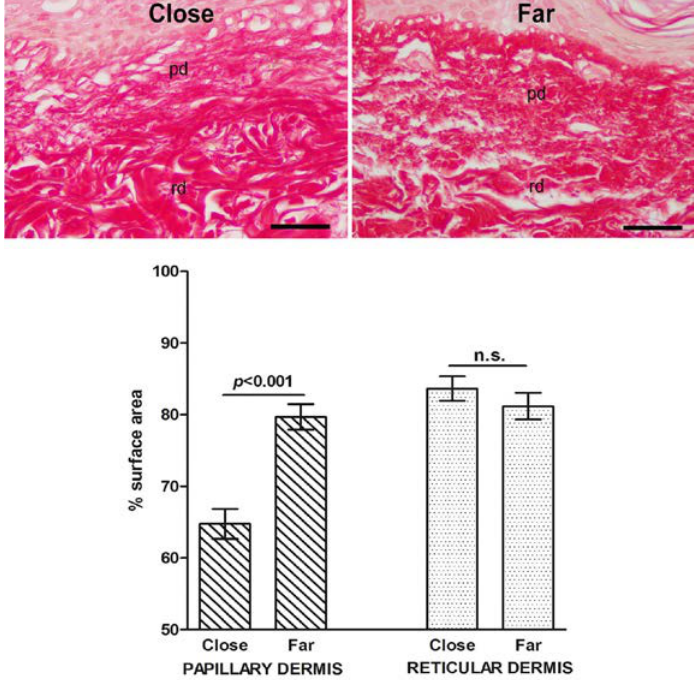
Figure 4. Light microscopic appearance and morphometry of collagen fibers from skin areas located close to and far from (3–5 mm) the surgical wound; pd: papillary dermis, rd: reticular dermis. The collagen fiber meshwork is slightly, albeit significantly, reduced in proximity to the wound. PSR staining; bars = 100 µm; values are mean ± s.e.m., n = 4, n.s. not significant.